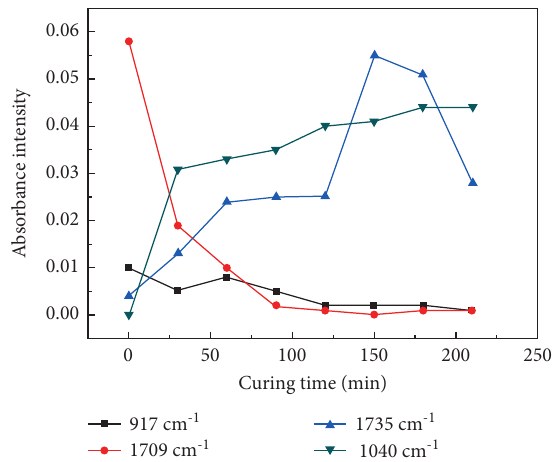
Figure 16: Evolution of epoxy group (917cm − 1 ), carbonyl acid (1709cm − 1 ), carbonyl ester (1735cm − 1 ), and carbonyl ether (1040cm − 1 )